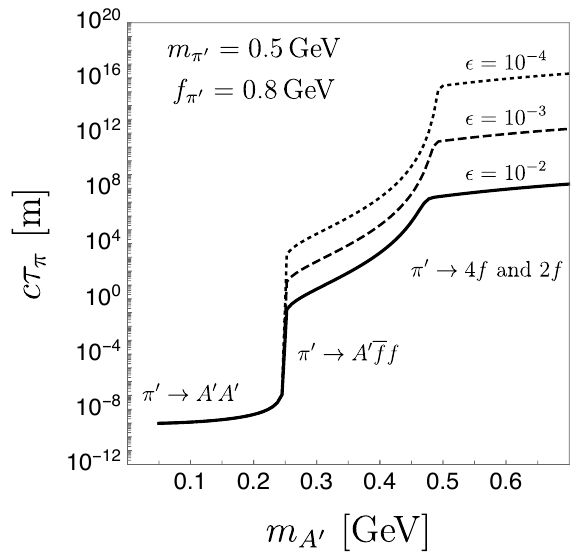
Figure 2 . Decay lengths of dark-neutral pions: the kinetic mixing is assumed to be (cid:15) = 10 − 2 (solid), (cid:15) = 10 − 3 (dashed), and (cid:15) = 10 − 4 (dotted). We take α 0 = 0 . 05 , m π 0 = 0 . 5 GeV , f π 0 = 0 . 8 GeV . We include all possible final state for π 0 3 → A 0 f ¯ f , but include only leptonic final states for π 0 3 → f ¯ f and π 0 3 → f ¯ ff 0 ¯ f 0